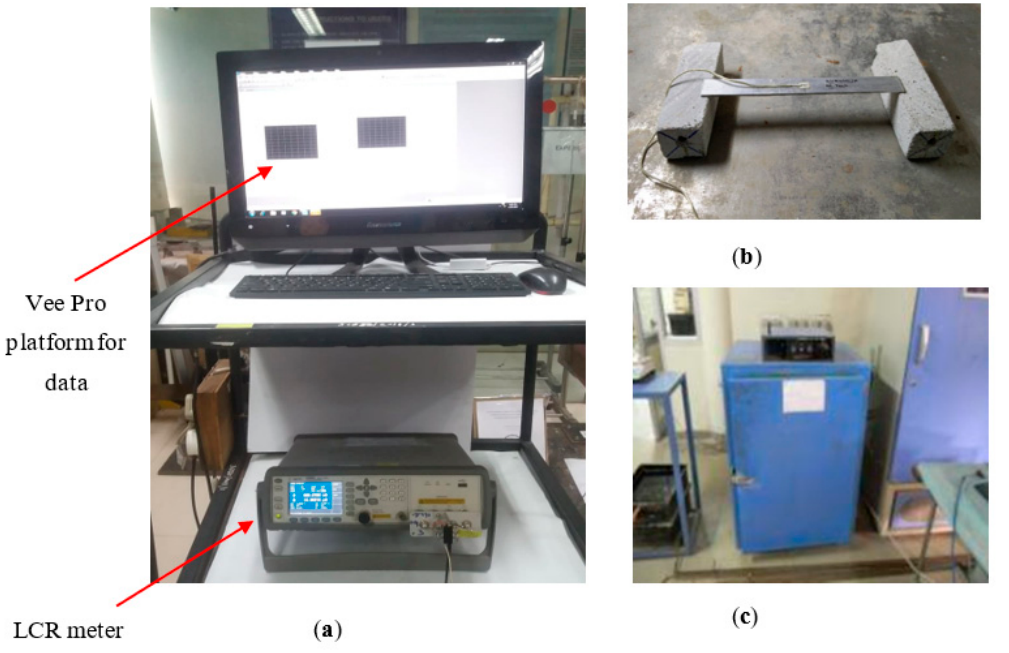
Figure 2. Experiment setup, ( a ) LCR meter and Vee-Pro platform, ( b ) setup for sensor bonded on the aluminum beam, and ( c ) oven used in the testing.